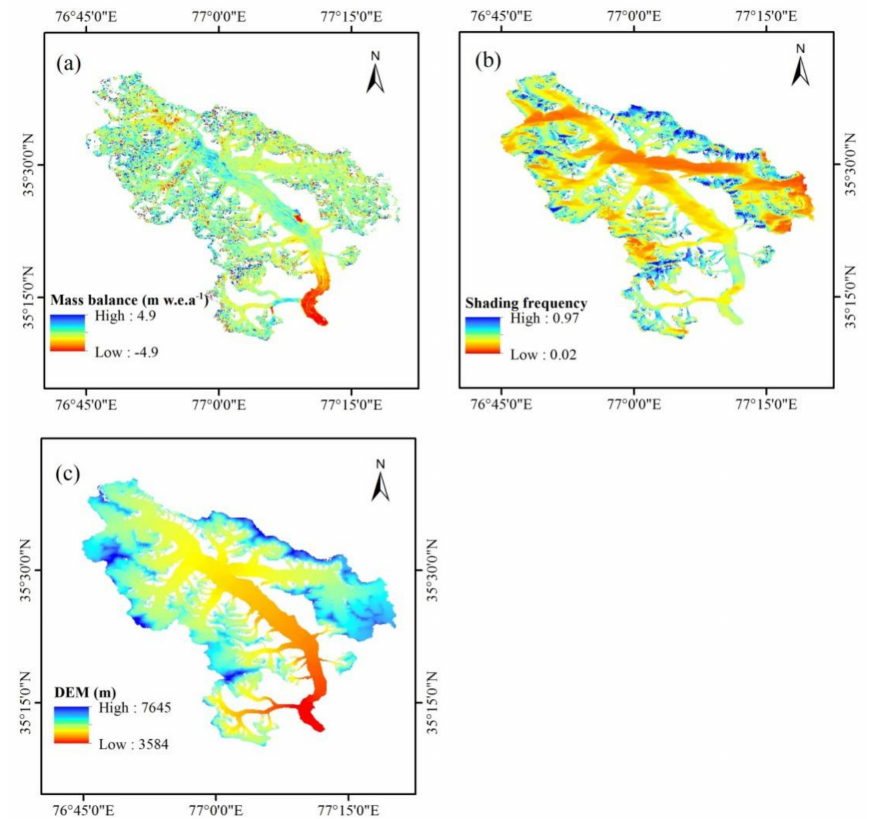
Figure 10. Comparison between the mass balance ( a ), topographic shading ( b ) and DEM ( c ) of Glacier RGI60-14.07524.